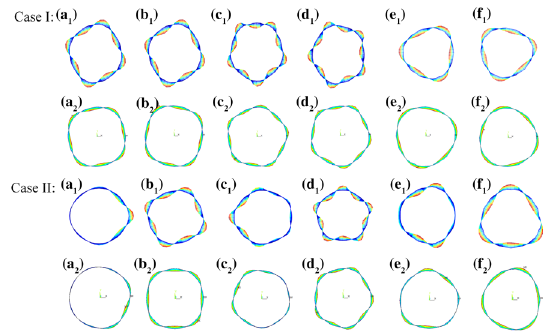
Figure 3 Comparison of mode shapes of the cylindrical shell with tuned bolted joints for Case I and Case II: a The first order; b the second order; c the third order; d the forth order; e the fifth order; f the sixth order (subscript 1 represents the results by the presented method, subscript 2 represents the results by